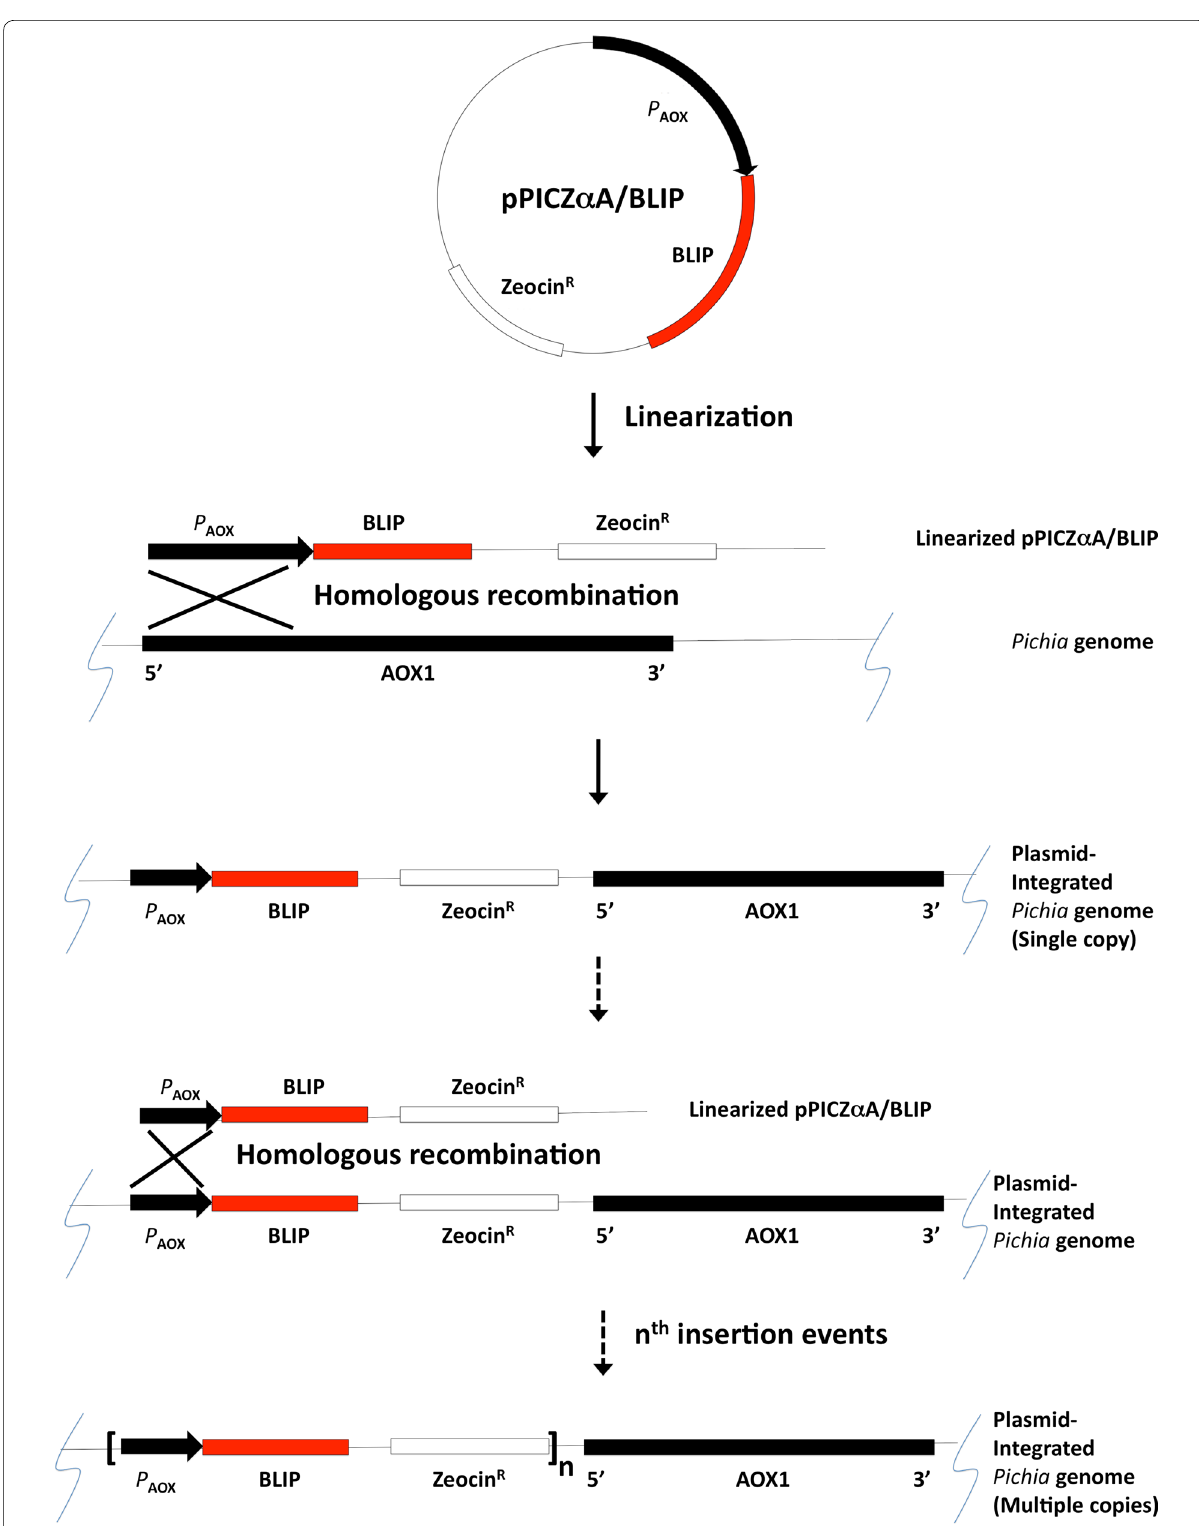
Fig. 2 Integration of pPICZαA/BLIP into genome of P. pastoris X‑33 via homologous recombination. ( P AOX AOX1 promoter, BLIP expression cassette of BLIP including the α‑factor signal sequence, blip gene and blip transcription terminator, Zeocin R Zeocin resistance gene, AOX AOX1